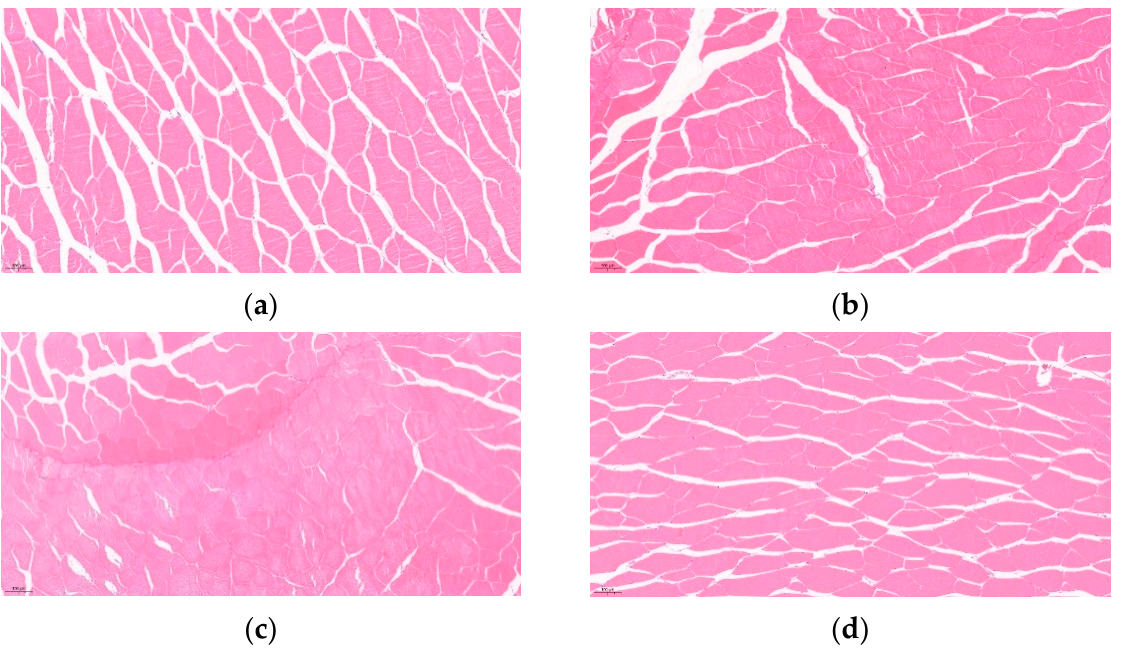
Figure 3. The effect of respite time on cross ‐ sectional cytoarchitecture of blunt snout bream after live transportation: ( a ) 0 h, ( b ) 24 h, ( c ) 48 h, and ( d ) 72 h. Muscle fiber microstructure with 100 times magnification.